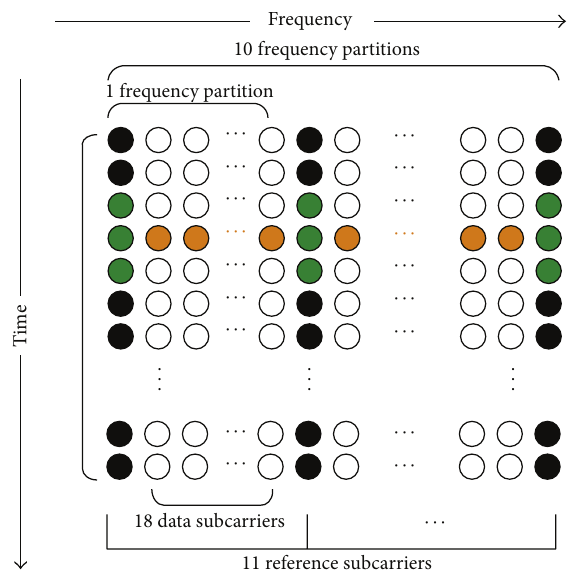
Figure10:Timedomainaveragingbyusinga3-elementslidingwin- dow.